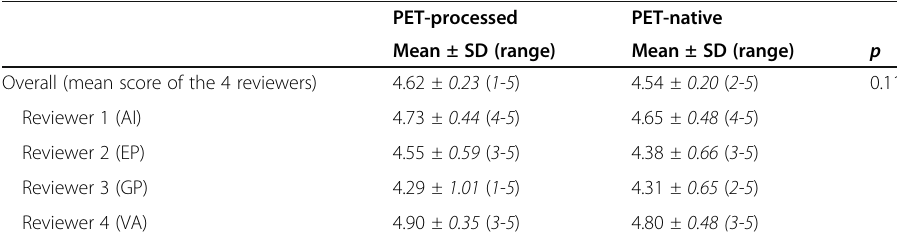
Table 2 Image quality assessment using a 5-point scale. The analysis was performed considering the mean score of the four reviewers and the score assigned by each individual reviewer PET-processed